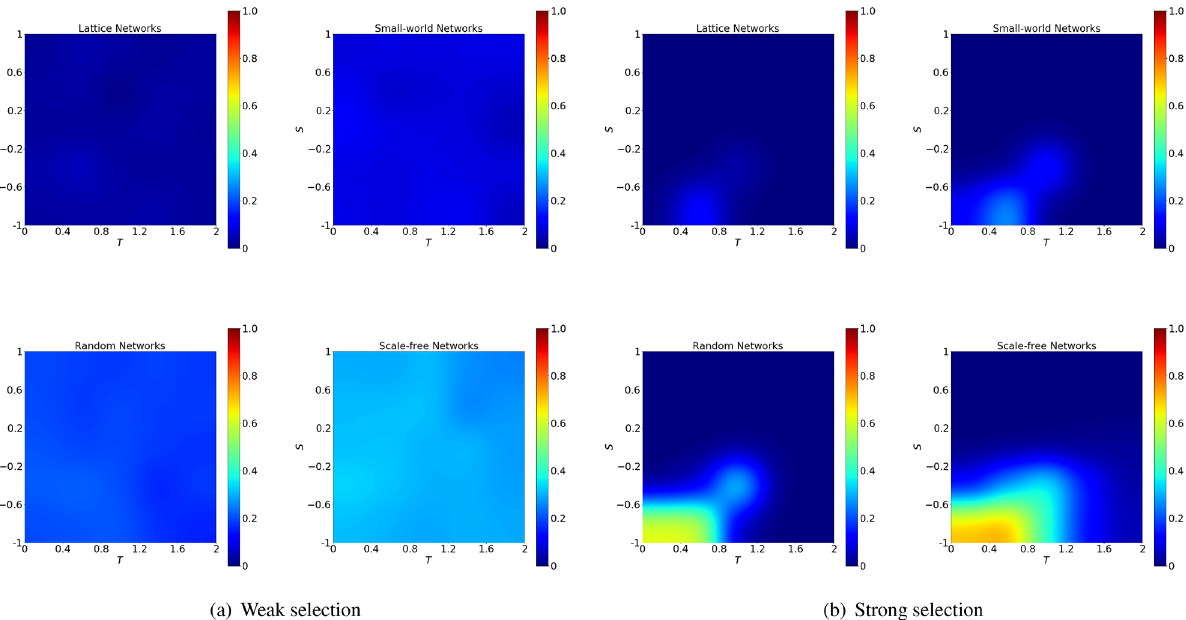
Figure 9. Difference of performance between the best ranking and the random ranking is evident at strong selection for stag-hunt games in scale-free networks. The figures show the difference in the probability of cooperation restoration between the one obtained by using the random ranking and the one obtained using the best structural ranking (i.e., the one which gives the highest probability of cooperation restoration). The biggest gap is obtained in scale-free networks, stag-hunt game and for strong selection. For a fixed initial density ρ = 30% , we show the gap between the best performing ranking and the random ranking at weak selection w = 0.001 (left panels) and strong selection with w = 0.1 (right panels). The networks considered are lattice, small-world, random and scale-free, respectively. For each subfigure, the x-axis indicates the game parameter T ∈ [ 0, 2 ] and the y-axis indicates the game parameter S ∈ [− 1, 1 ]